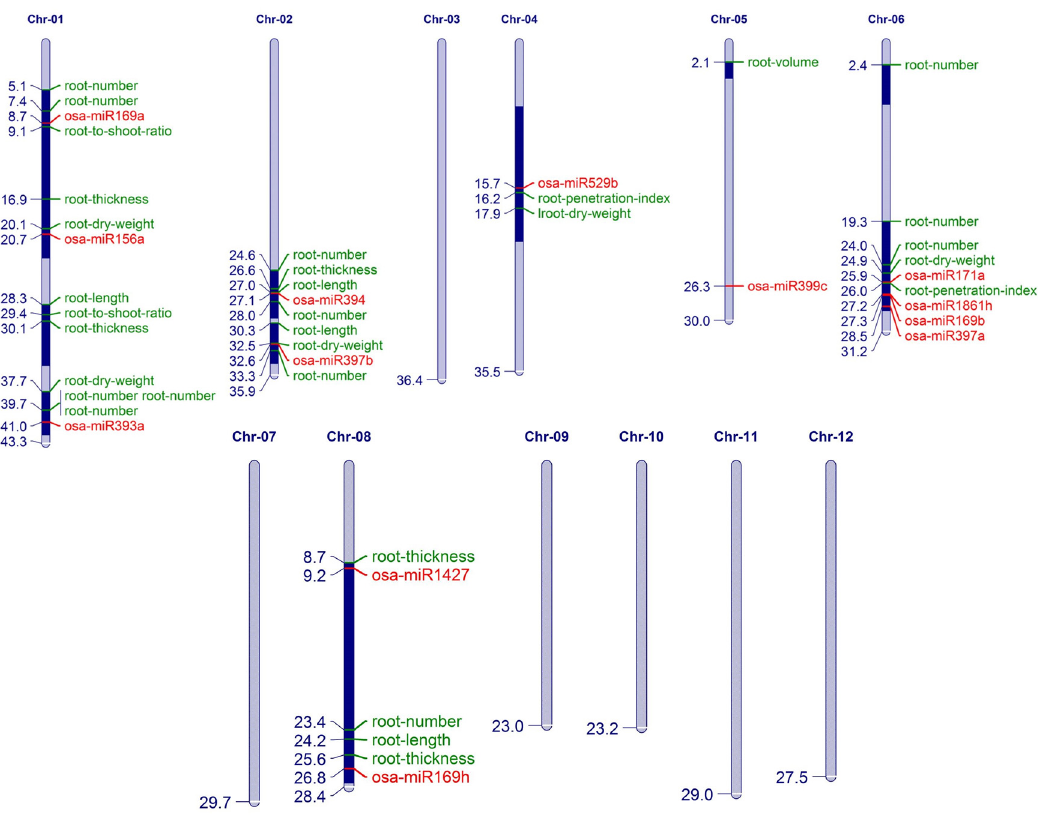
Figure 6. Physical map of rice chromosomes to show the association of miRs with root trait-related Quantitative trait loci (QTLs). The position of miRs and QTLs are mentioned on the left side (in Mbps) and the respective miR and QTL IDs are provided on the right side.